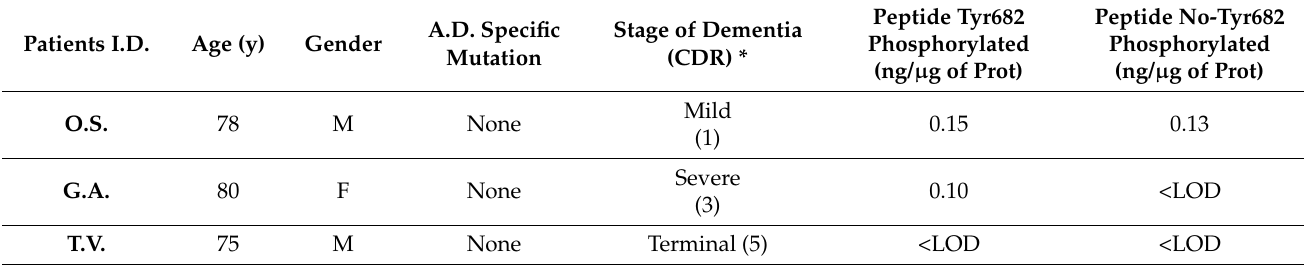
Table 5. Detailed information of patients studied and amounts of peptides extracted after the in-gel digestion of APP.